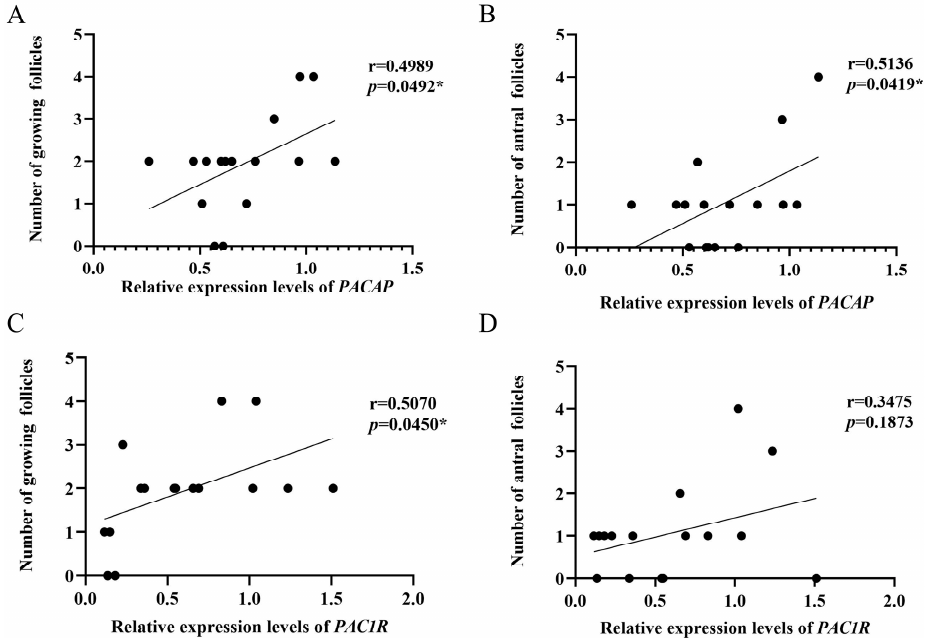
Figure 6. Correlation analysis between the PACAP/PAC1R expression and growing follicles number and antral follicles number in Phodopus sungorus . ( A ) Correlation analysis between PACAP expression and growing follicles number. ( B ) Correlation analysis between PACAP expression and antral follicles number. ( C ) Correlation analysis between PAC1R expression and growing follicles number. ( D ) Correlation analysis between PAC1R expression and antral follicles number (* p < 0.05).